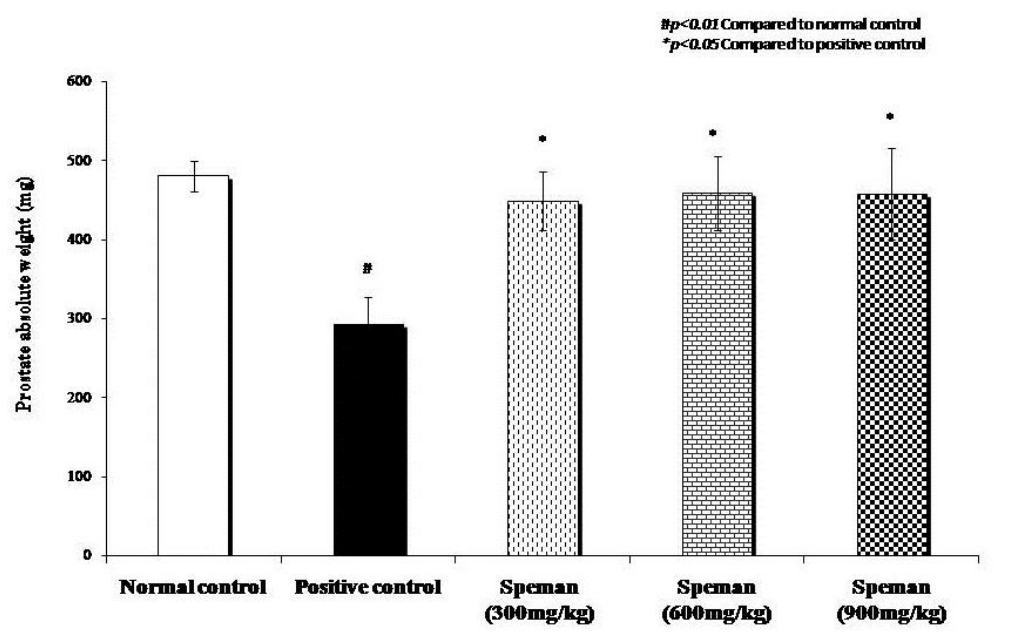
Figure 4: Effect of Speman ® on absolute weight of prostate in an experimental model of CP- induced oligospermia in